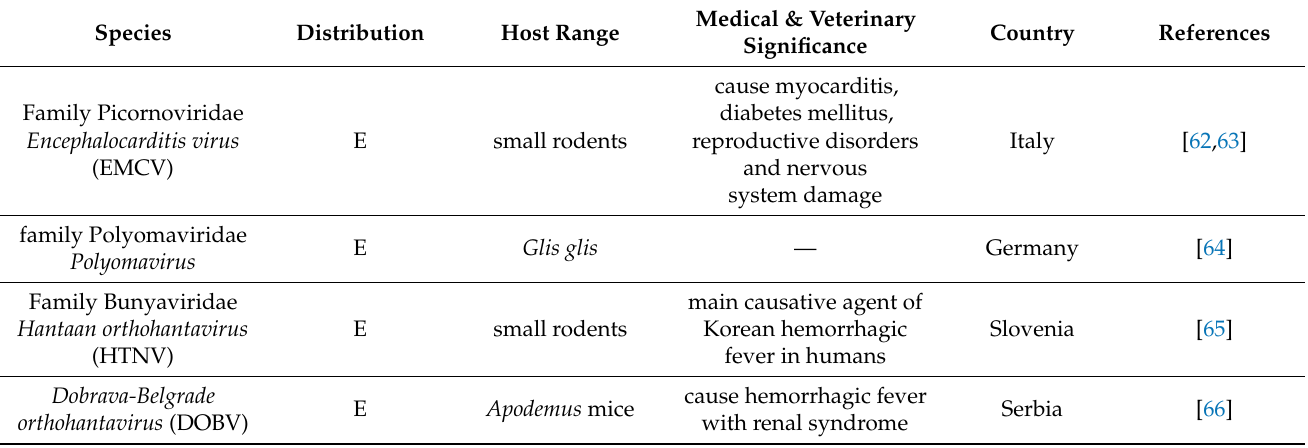
Table 1. Viruses of Glis glis in Western Palaearctic.